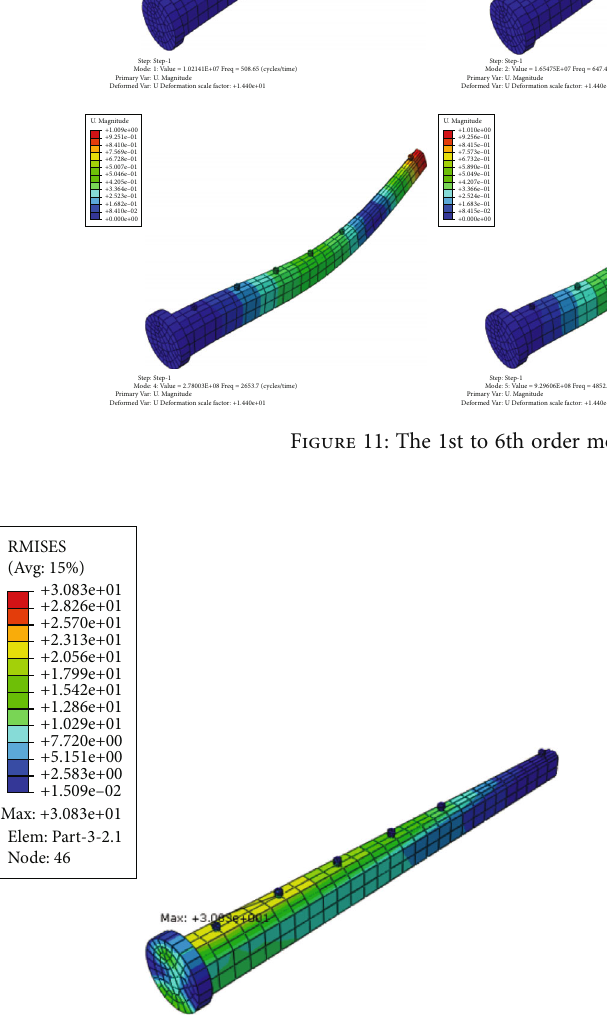
Figure 12: RMS stress cloud diagram of test probe. Table 8: Fatigue life under three stress